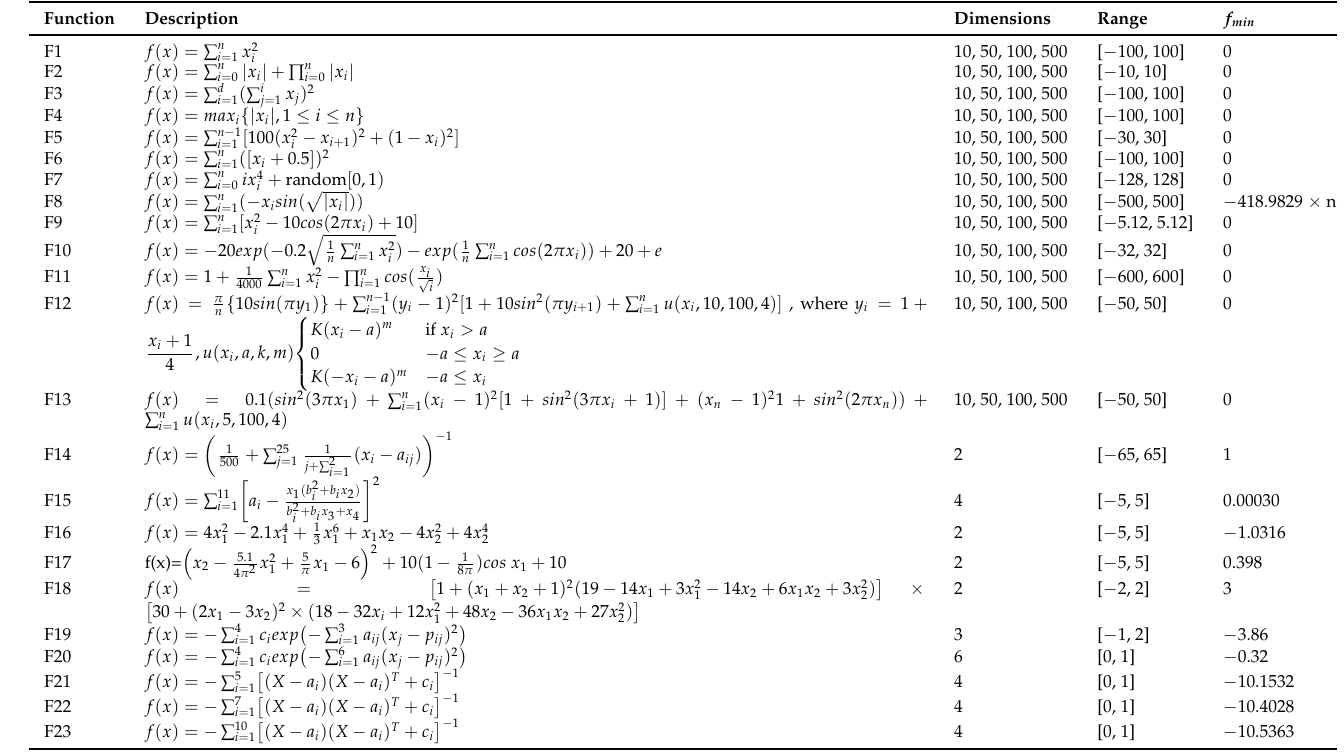
Table 3. Classical benchmark functions.